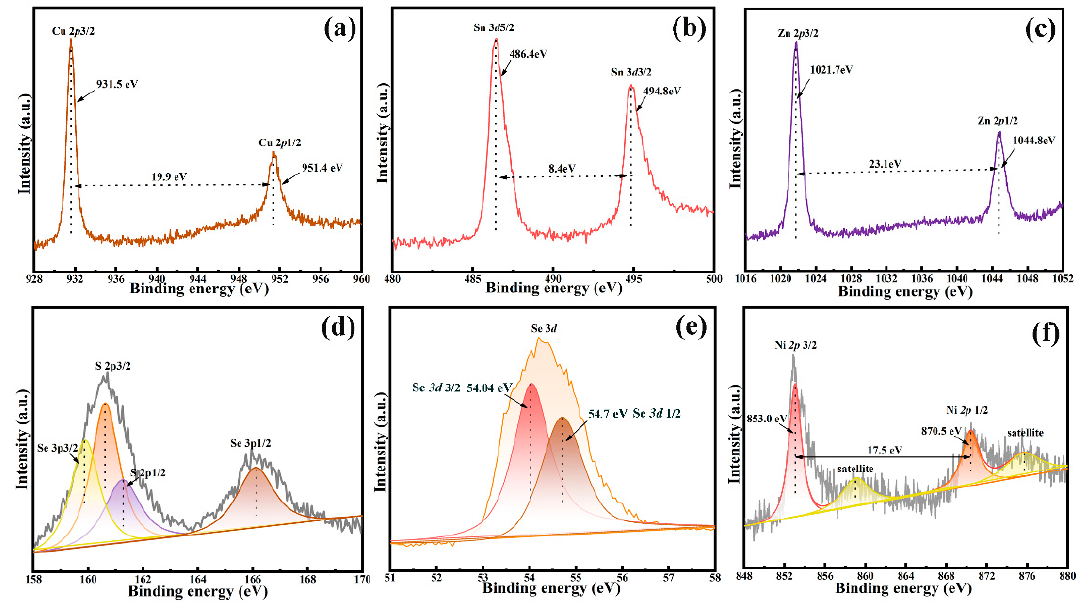
Figure 6. XPS spectra of CNZTSSe films selenized at 15 min: ( a ) Cu 2p, ( b ) Sn 3d, ( c ) Zn 2p, ( d ) S 2p, ( e ) Se 3d and ( f ) Ni 2p.